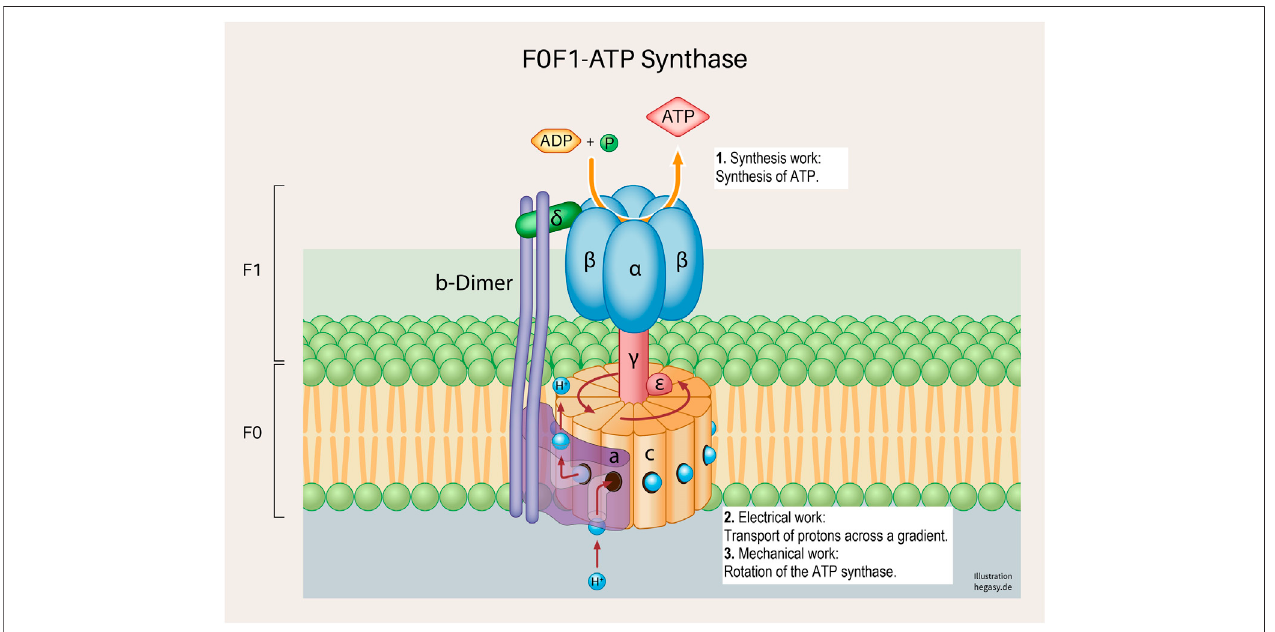
FIGURE4| Asubunitofthecellrespirationdescribedabove;theF0F1ATPsynthetasesystemintheinnermitochondrialmembrane(Neupaneetal.,2019).Various formsofcellworkareinvolved,andwhicharenecessaryforacorrectprocess:synthesiswork(1),electricalwork(2),andmechanicalwork(3).Theseworkingprocesses are also, as already described above, not only in fl uenced by the regular structure of the proteins but are also dependent on the surrounding biological energy, the milieu and mechanical in fl uences.